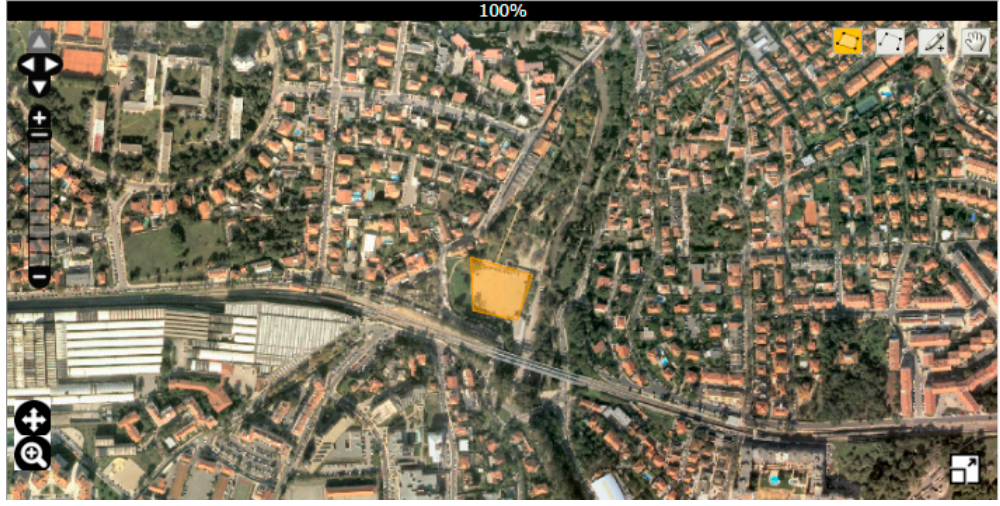
Figure 11. Polygon used in third scenario.